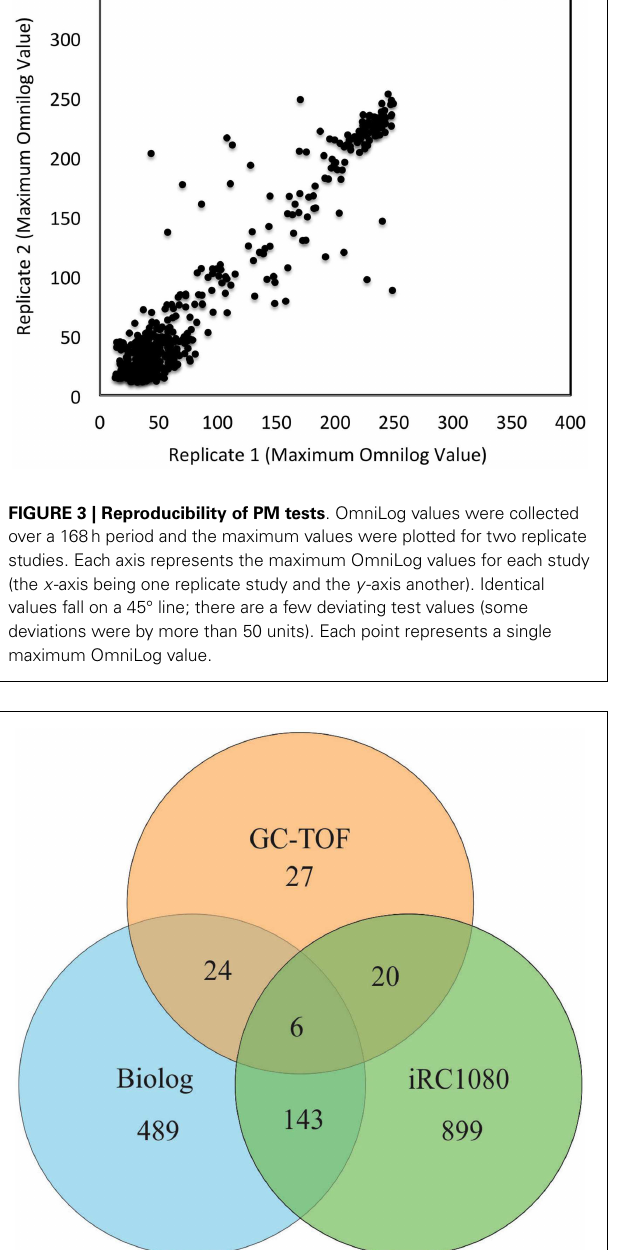
FIGURE 4 |Venn diagram of metabolites .TheVenn diagram is a representation of metabolites common to Biolog’s PM plates, the iRC1080 metabolic model and Gas Chromatography time-of-flight (GC-TOF) experiments. Each circle indicates the total number of metabolites that exists in each respective method of study, while the overlapping regions represent the number of metabolites shared between those methods of study.The iRC1080 metabolic model contains a total of 1,068 unique metabolites, the GC-TOF identified a total of 77 metabolites (Bölling and Fiehn, 2005), while there are a total of 662 metabolites tested using Biolog’s PM